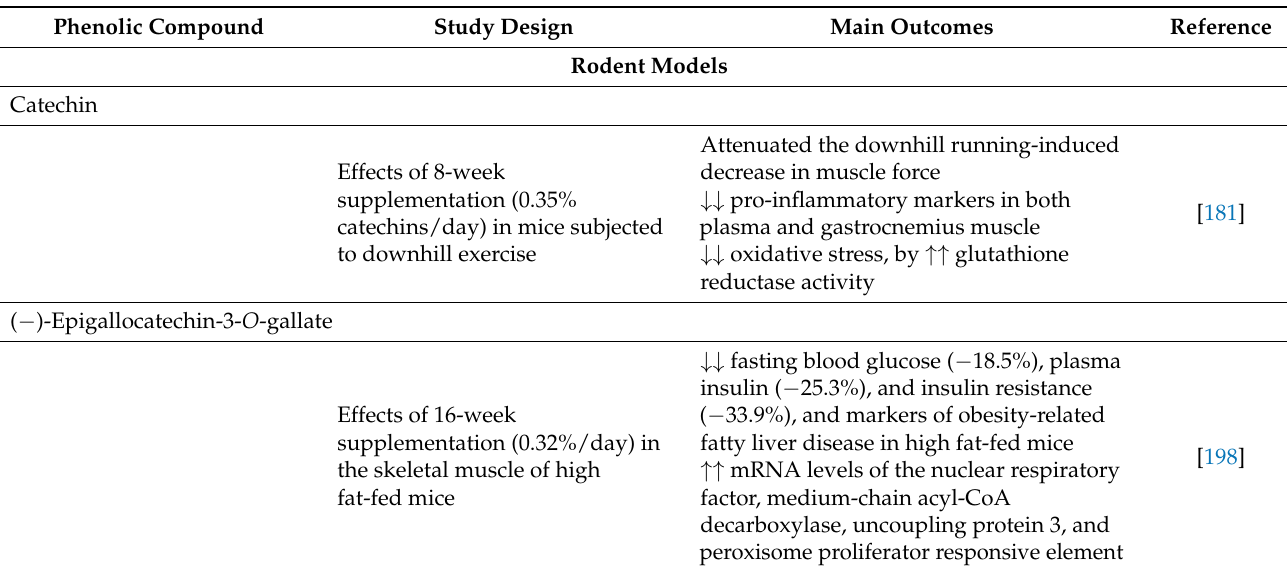
Table 1. Main effects of phenolic compounds in